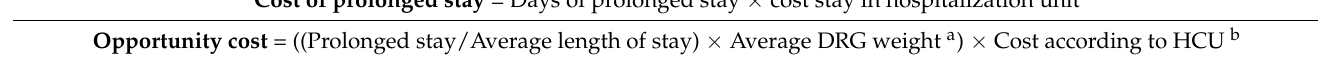
Table 1. Calculation formulas for the costs of each period of stay. Cantabria (northern Spain), 2007–2015. Cost of appropriate stay = Days of appropriate stay × cost stay per DRG a Cost of prolonged stay = Days of prolonged stay × cost stay in hospitalization unit Opportunity cost = ((Prolonged stay/Average length of stay) × Average DRG weight a ) × Cost according to HCU b a DRG, diagnostic related group; b HCU, hospital complexity